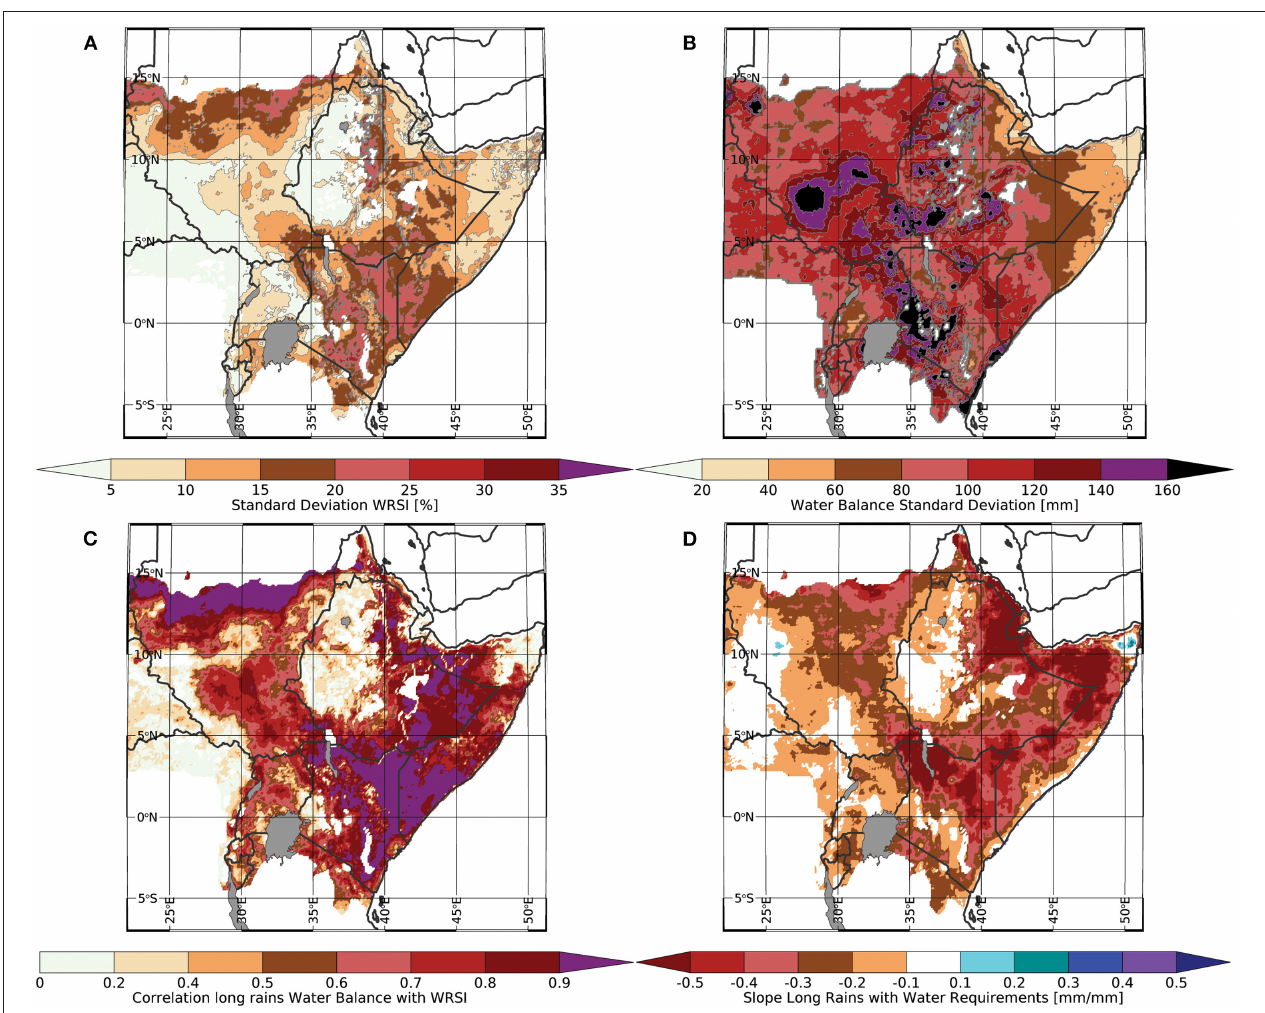
were not statistically distinguishable. The WRSI did not perform better than the